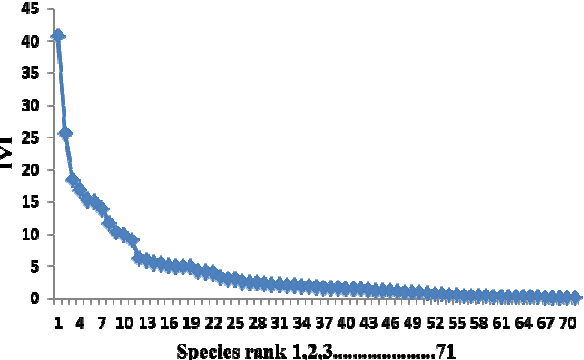
Fig. 2. Dominance diversity (D-D) curve for tree species in dry decidous tropical Table 1. Diversity parameters (per quadrat) in dry deciduous tropical